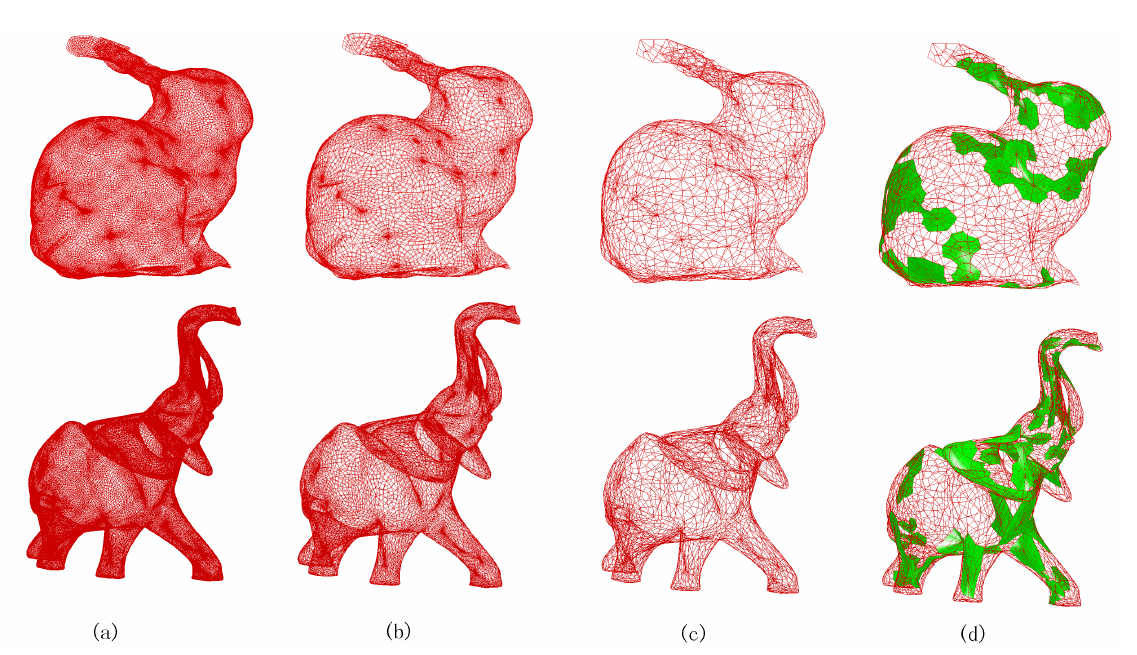
Figure 10. Mesh sequences in different resolution: (a) the original meshes; (b) the meshes by wavelet analysis once; (c) the meshes by wavelet analysis twice; (d) the surface of polar structures by wavelet analysis twice.